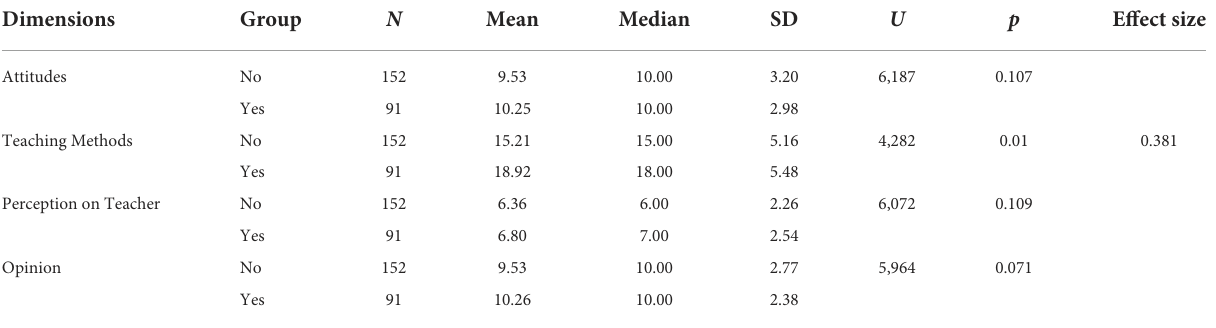
TABLE 6 Mann–Whitney U results according to presence of